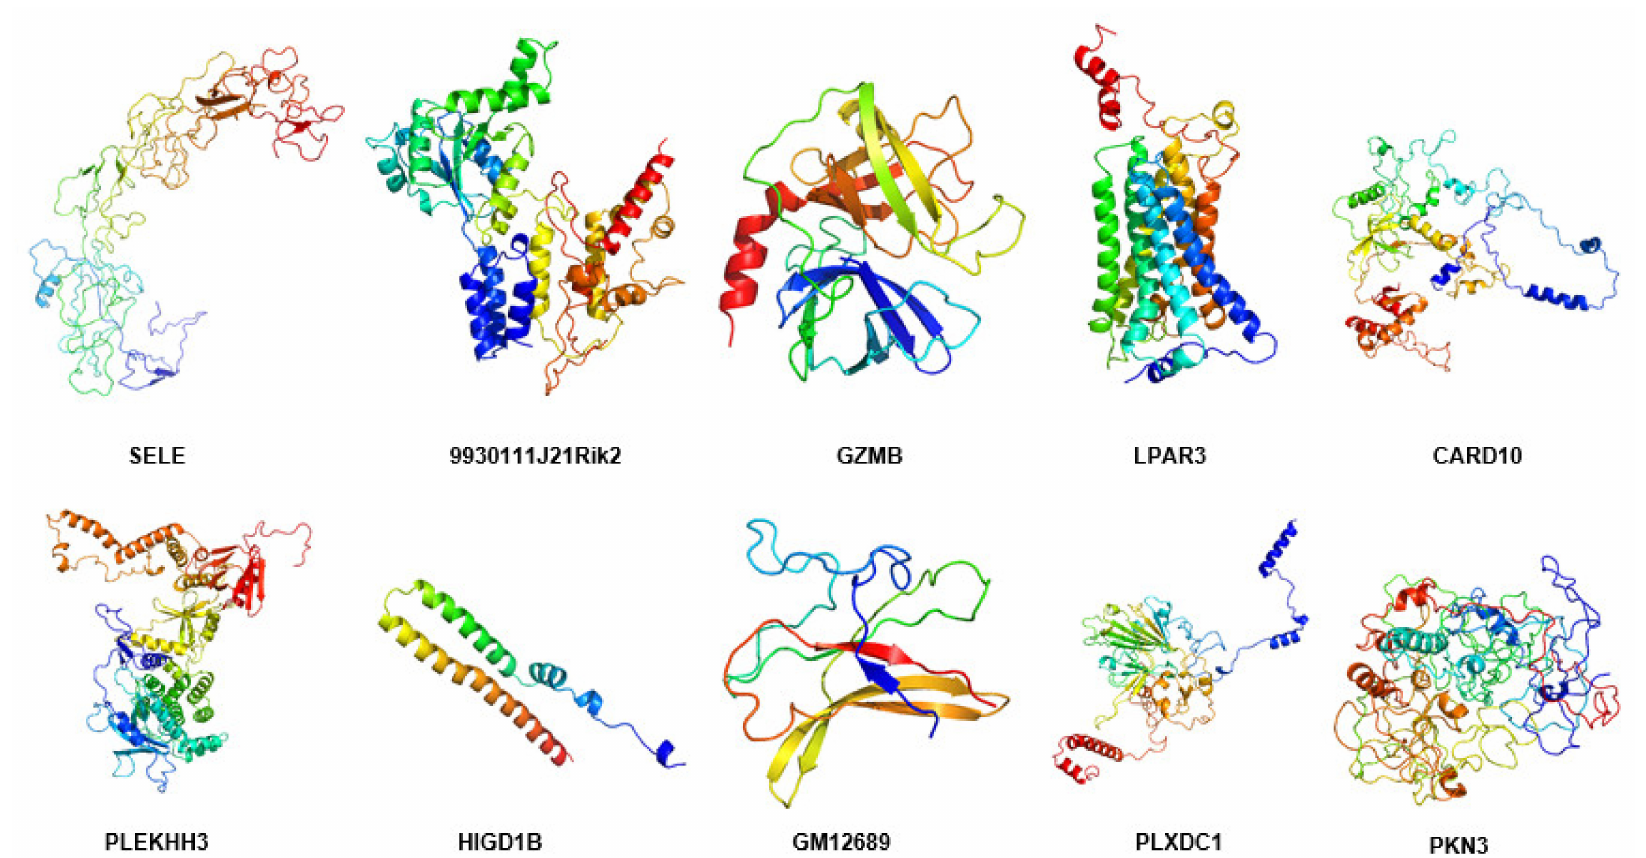
Figure 13. The 3-D view of hub proteins. After molecular dynamics optimization, the three-dimensional view of the hub proteins was demonstrated, including SELE, 9930111J21RIK2, GZMB, LPAR3, CARD10, PLEKHH3, HIGD1B, GM12689, PLXDC1, and PKN3. Figures were generated by using the Pymol